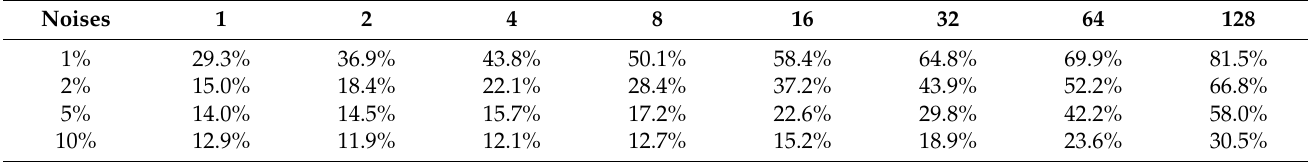
Table 6. Detection results of the EfficientNetB0 within the background with separated noises.